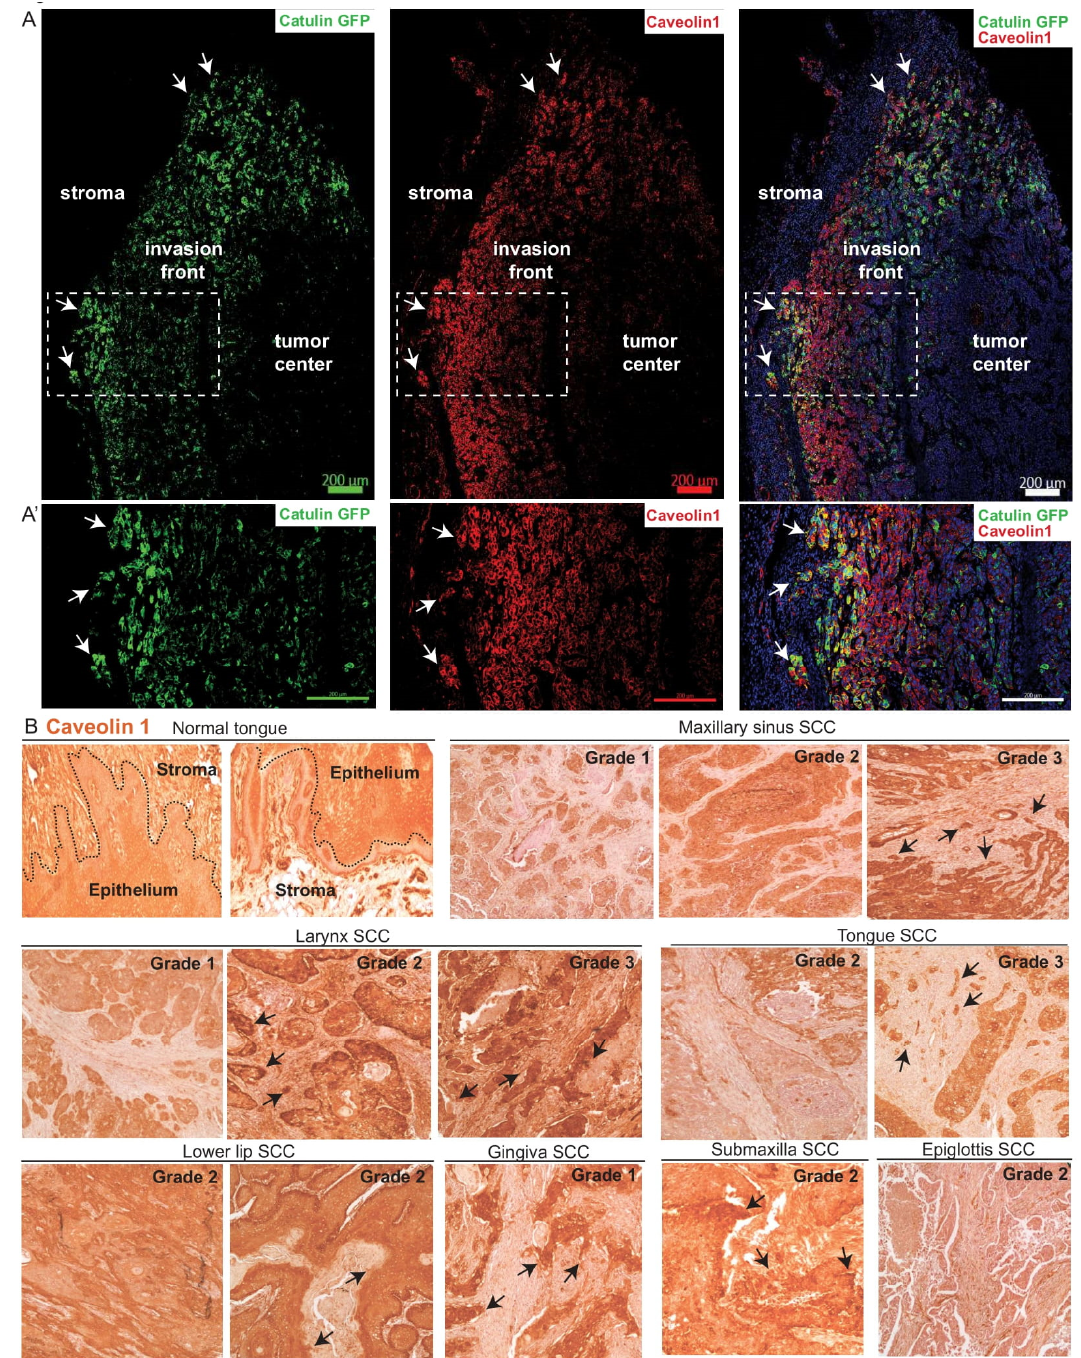
Figure 7. Caveolin-1 localization in Catulin-GFP reporter tumor and in human HNSCC cancer tissues. ( A ) Immunofluorescence staining of the section of tumor formed after the injection of SCC15CatGFP and with the use of the caveolin-1 antibody. GFP (catulin reporter) immunofluorescence is indicated in green, caveolin-1 immunofluorescence is indicated in red, and DAPI (nucleus) immunofluorescence is indicated in blue. The boxed area in ( A ) are enlarged in ( A (cid:48) ). Arrows indicate the co-localization of the catulin reporter with caveolin-1. Scale bar: 200 µ m. ( B ) Immunohistochemical DAB stainings of caveolin-1 in a tissue array of HNSCC samples and in normal human tongue tissue. Arrows indicate high caveolin-1 expression in potentially invasive cells. Tissue origin and tumor grade, as provided by the manufacturer, are indicated. The stroma/epithelium border in normal tongue tissue is